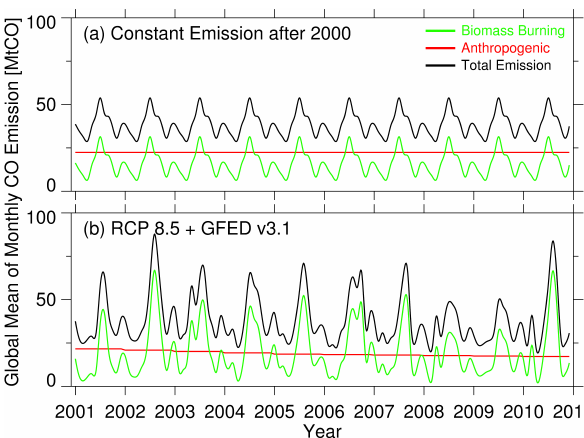
Figure 2. Time series of the global mean of monthly CO emissions: (a) a constant emission of RCP 8.5 and GFED v3.1 after 2000 and (b) the combination of RCP 8.5 and GFED v3.1.